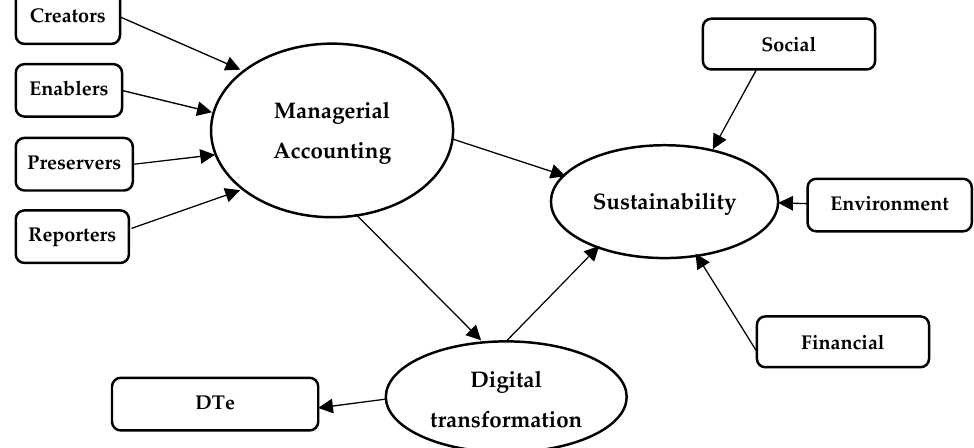
Figure 3. Theoretical model. Source: the authors’ design based on [2,15,28,29,32].